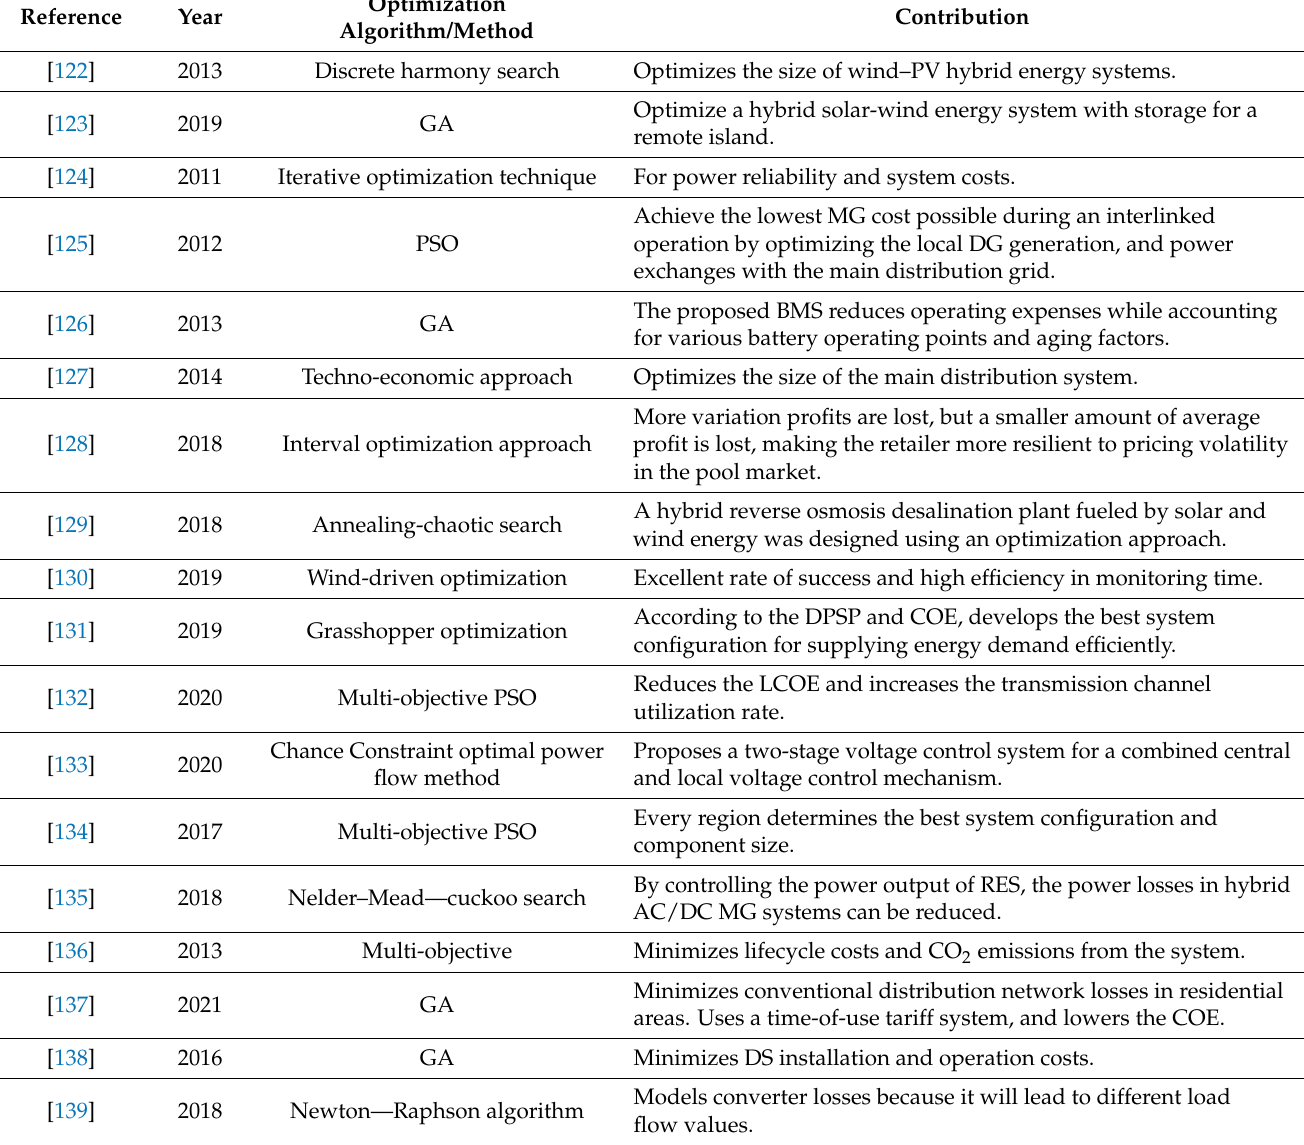
Table 7. Optimization methods in Hybrid AC/DC